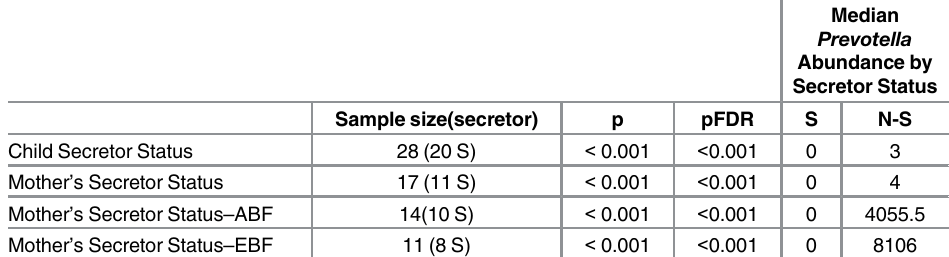
Table 3. Effect of secretor status on Prevotella abundance.